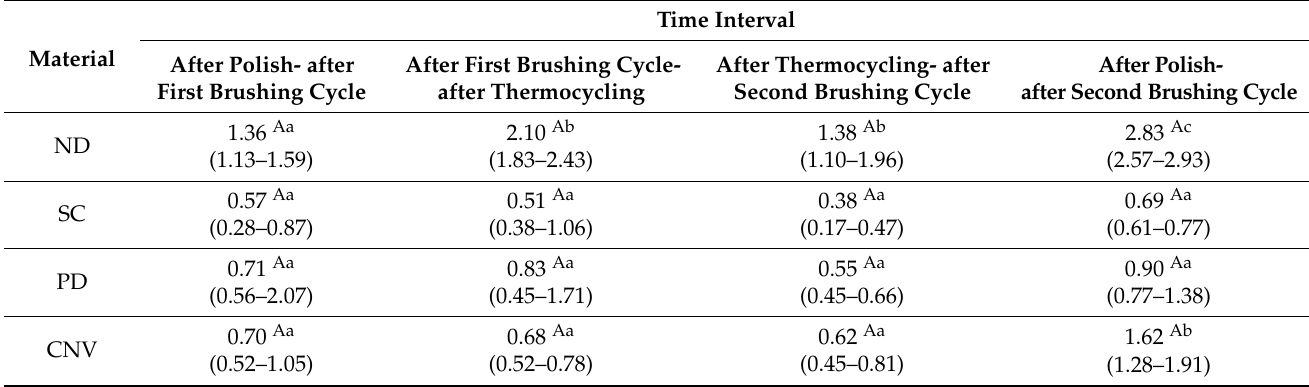
Table 3. Median and 95% confidence interval Δ E 00 values of each material between time intervals.